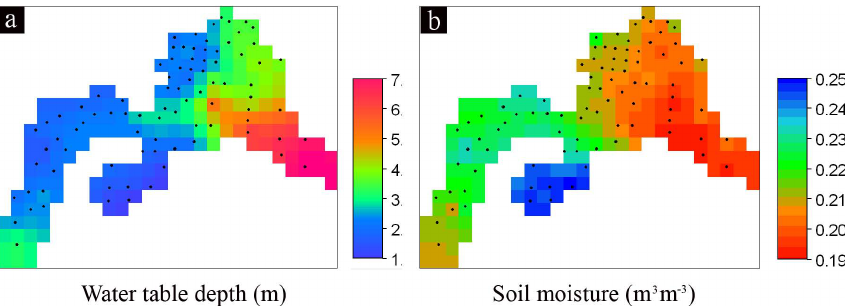
Fig. 3. The interpolated raster maps for (a) water table depth and (b) soil moisture of the upper 5cm. Locations of the point data collected in the field are also